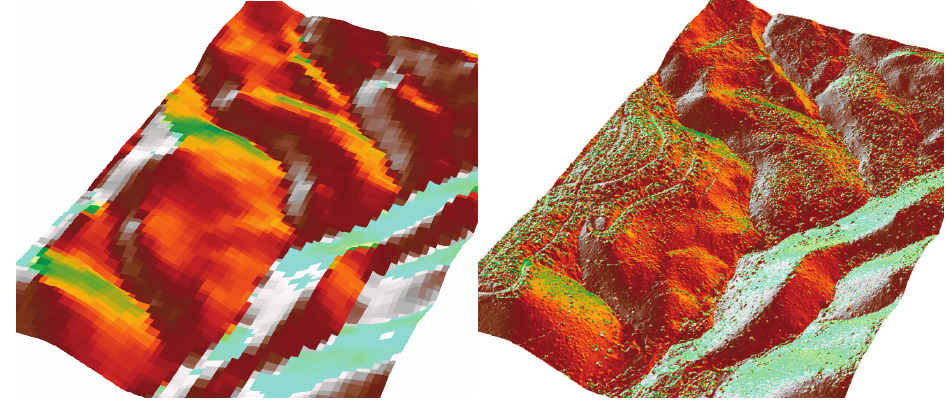
Figure 16. DTM ( left ) and LiDAR Digital Surface Model (DSM) ( right ) databases showing the same area—20 years apart.